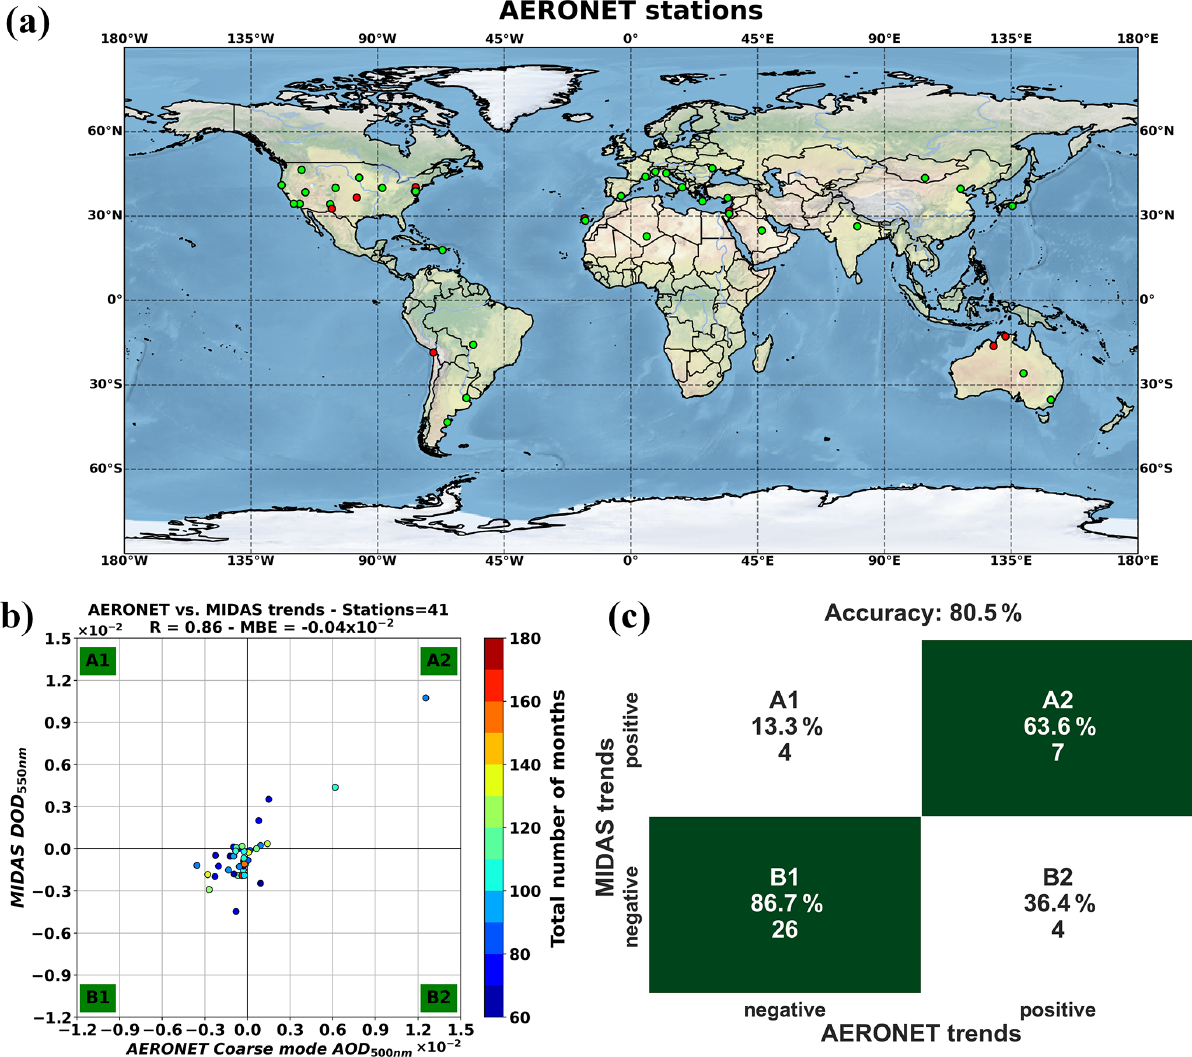
Figure 4. (a) Geographical location of the available AERONET stations for which the temporal trends of DOD and cAOD are calculated. Green and red dots refer to the stations with similar and different trend signs, respectively. (b) Scatter plot between MIDAS DOD and AERONET cAOD trends. The color bar indicates the total number of months. (c) Confusion matrix of possible trend signs among the two